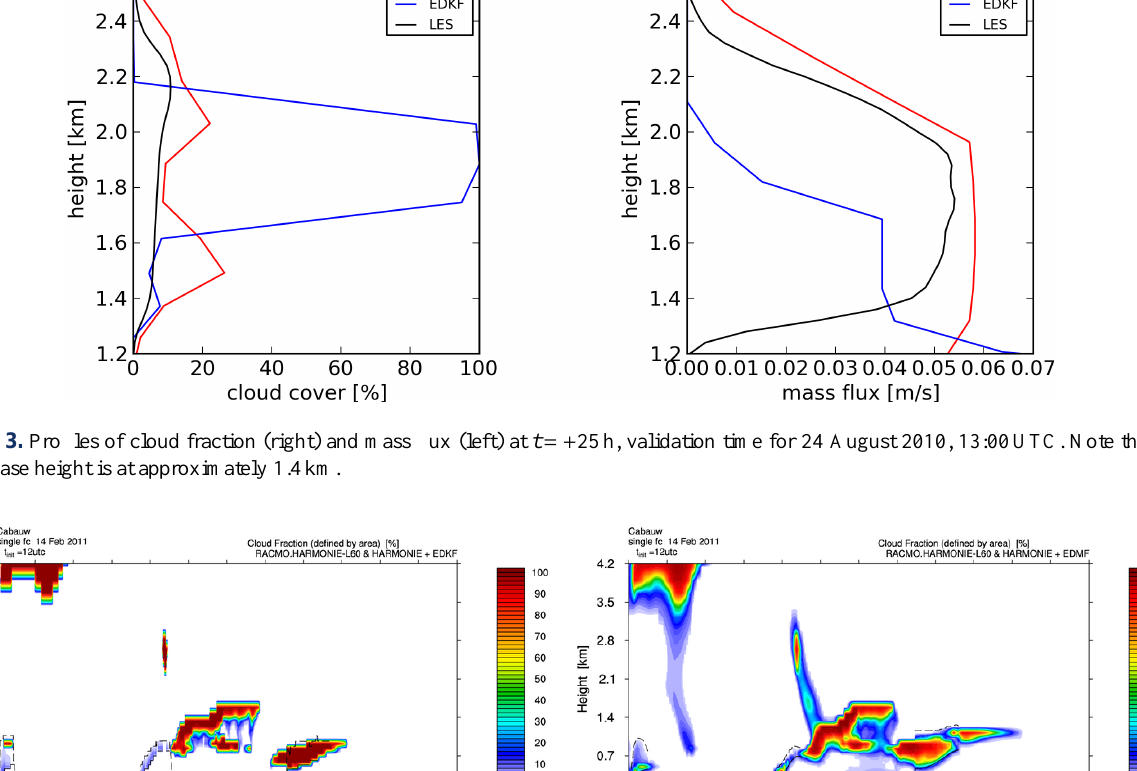
Figure 5. Synoptical visibility observations in [m] at Cabauw dur- ing 14-15 February 2011.